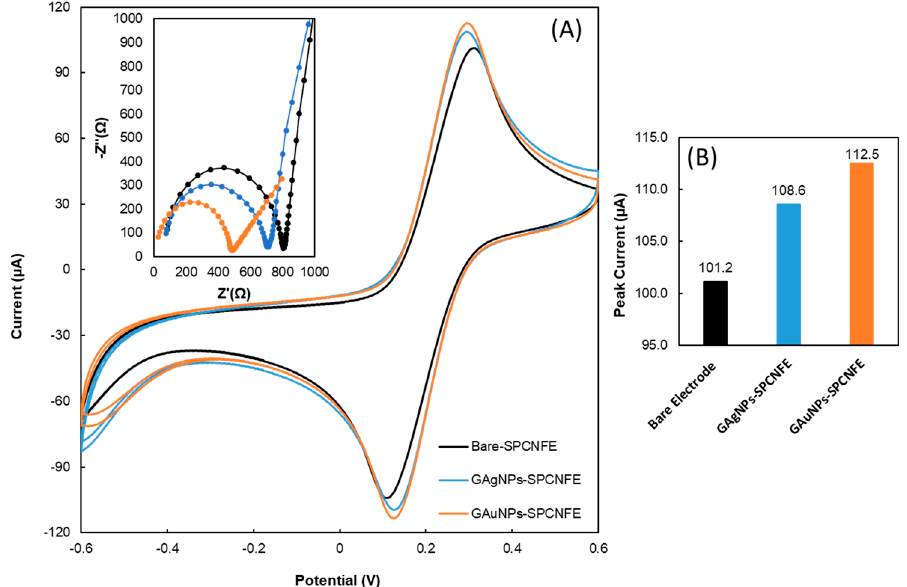
Figure 4. ( A ) Cyclic voltammograms, Inset: Nyquist diagram (recorded in 5 mmol L − 1 [Fe(CN) 6 ] − 3/ − 4 and 0.1 mol L − 1 KCl), and ( B ) bar graph of the bare screen-printed carbon nanofibers electrodes (SPCNFE), green synthesized silver and gold nanoparticles modified SPCNFE in 5 mmol L − 1 [Fe(CN) 6 ] − 3/ − 4 in acetic acid/acetate buffer 0.1 mol L − 1 pH 4.5.